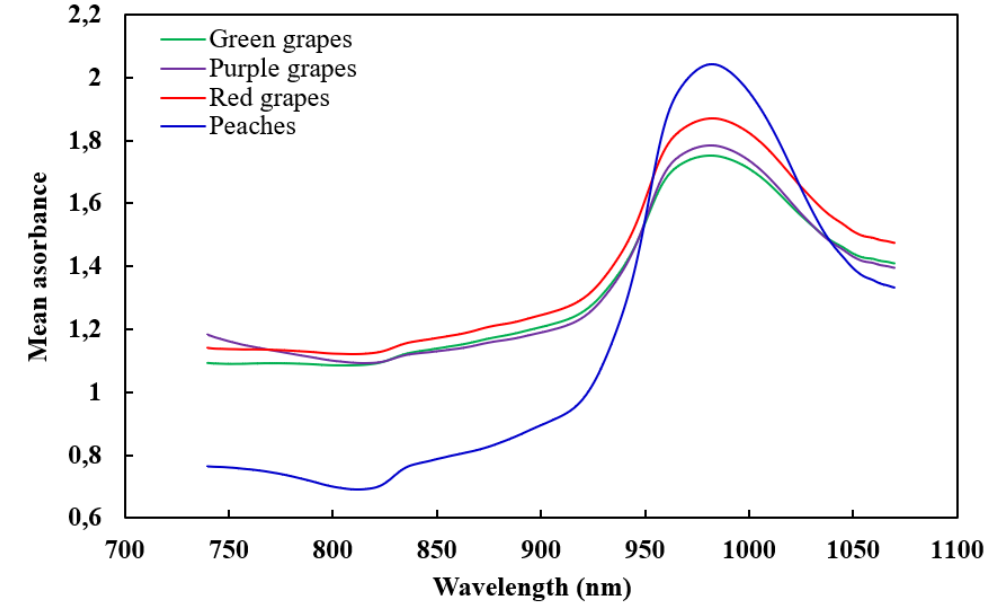
Figure 1. Absorbance spectra averaged per cultivar for 150 green grapes, 150 purple grapes, 150 red grapes and 150 peaches, acquired with the SCiO